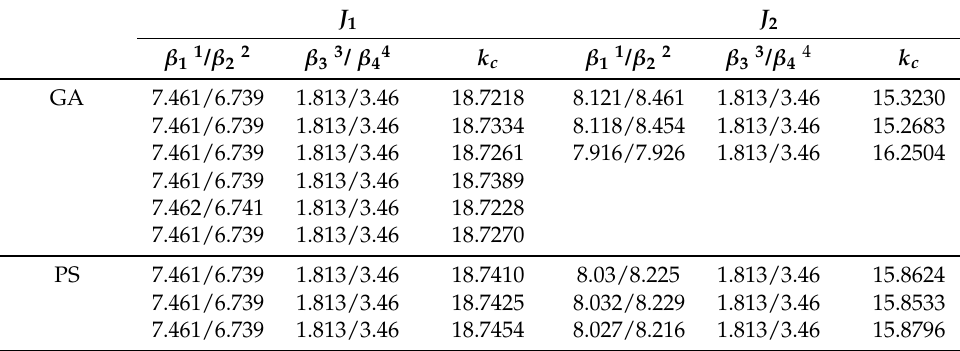
Table 3. Computed values for coefficients of controller’s transfer function (19). J 1 J